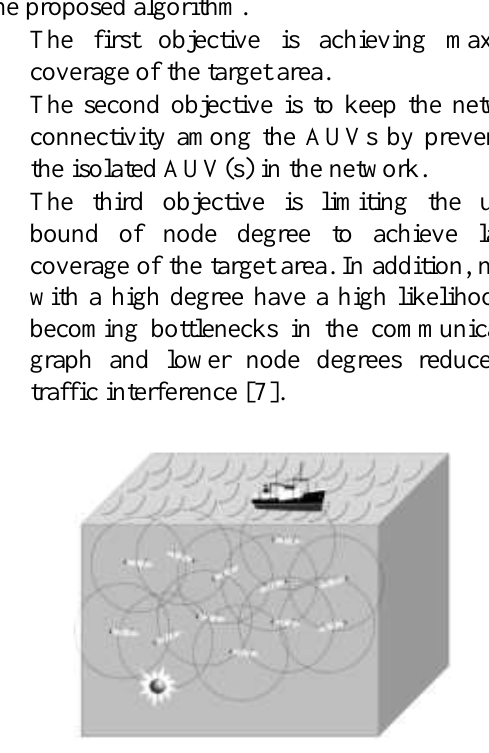
Figure 1. Several AUVs protecting an